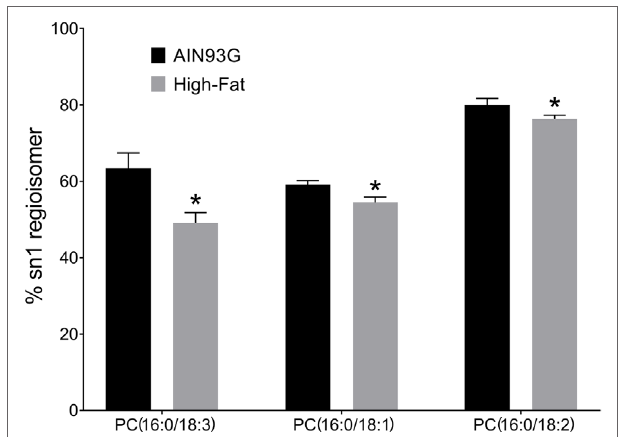
FigUre 4 | Volcano plot (a) and concentration of phosphatidylethanolamine [(PE); 18:2_20:2] (b) in the primary tumors of Lewis lung carcinoma with greater than twofold difference between the AIN93G diet and the high-fat diet. Values are mean ± SD ( n = 6 per group). * p < 0.05 for each comparison.